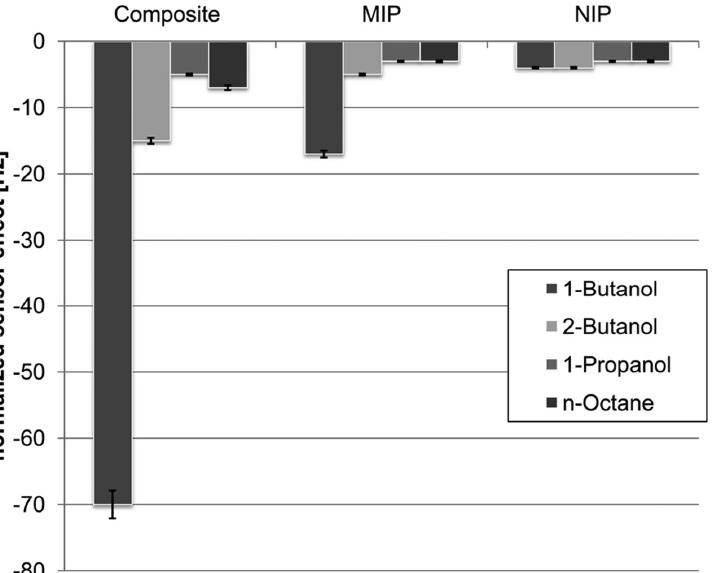
Figure 6. Results of selectivity studies (400 ppm) with a 1–butanol porogen imprinted polymer–Ag 2 S nanoparticle composites. Polyurethane MIPs were synthesized in 1–butanol with Ag 2 S particles (50 nm), and spin-coated onto a quartz crystal microbalance. Comparison was made between the MIP composite produced in this manner, MIPs produced without the Ag 2 S nanoparticles, and